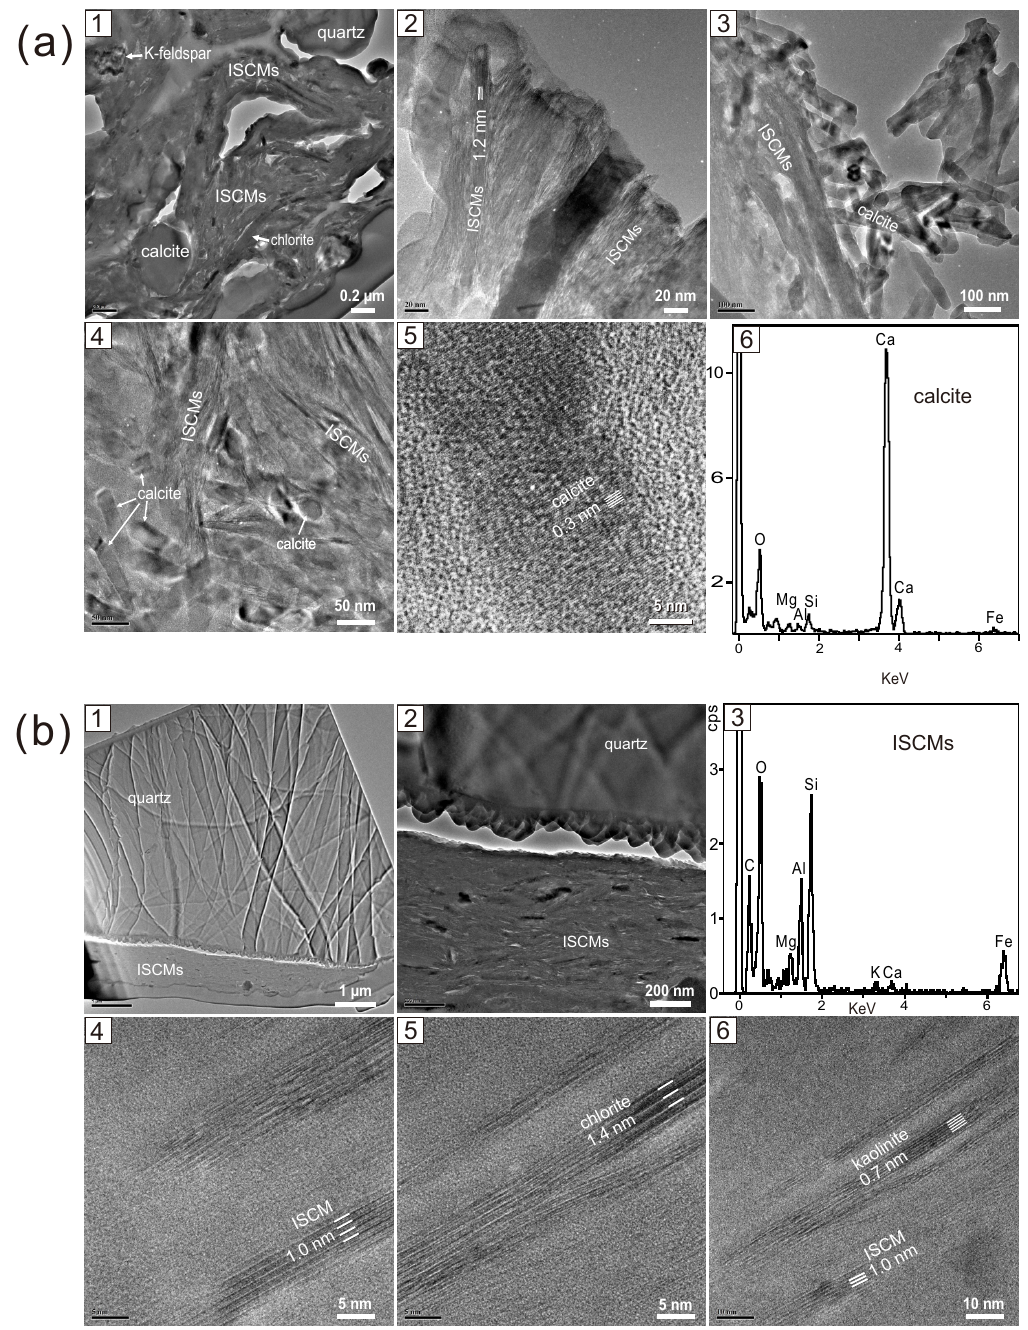
Fig. 5. TEM microtextures and lattice fringe images of giant dust particles with EDX spectra. (a) FIB slice of the clayey agglomerate dust particle in Fig. 4e. (b) FIB slice of the quartz dust particle in Fig.